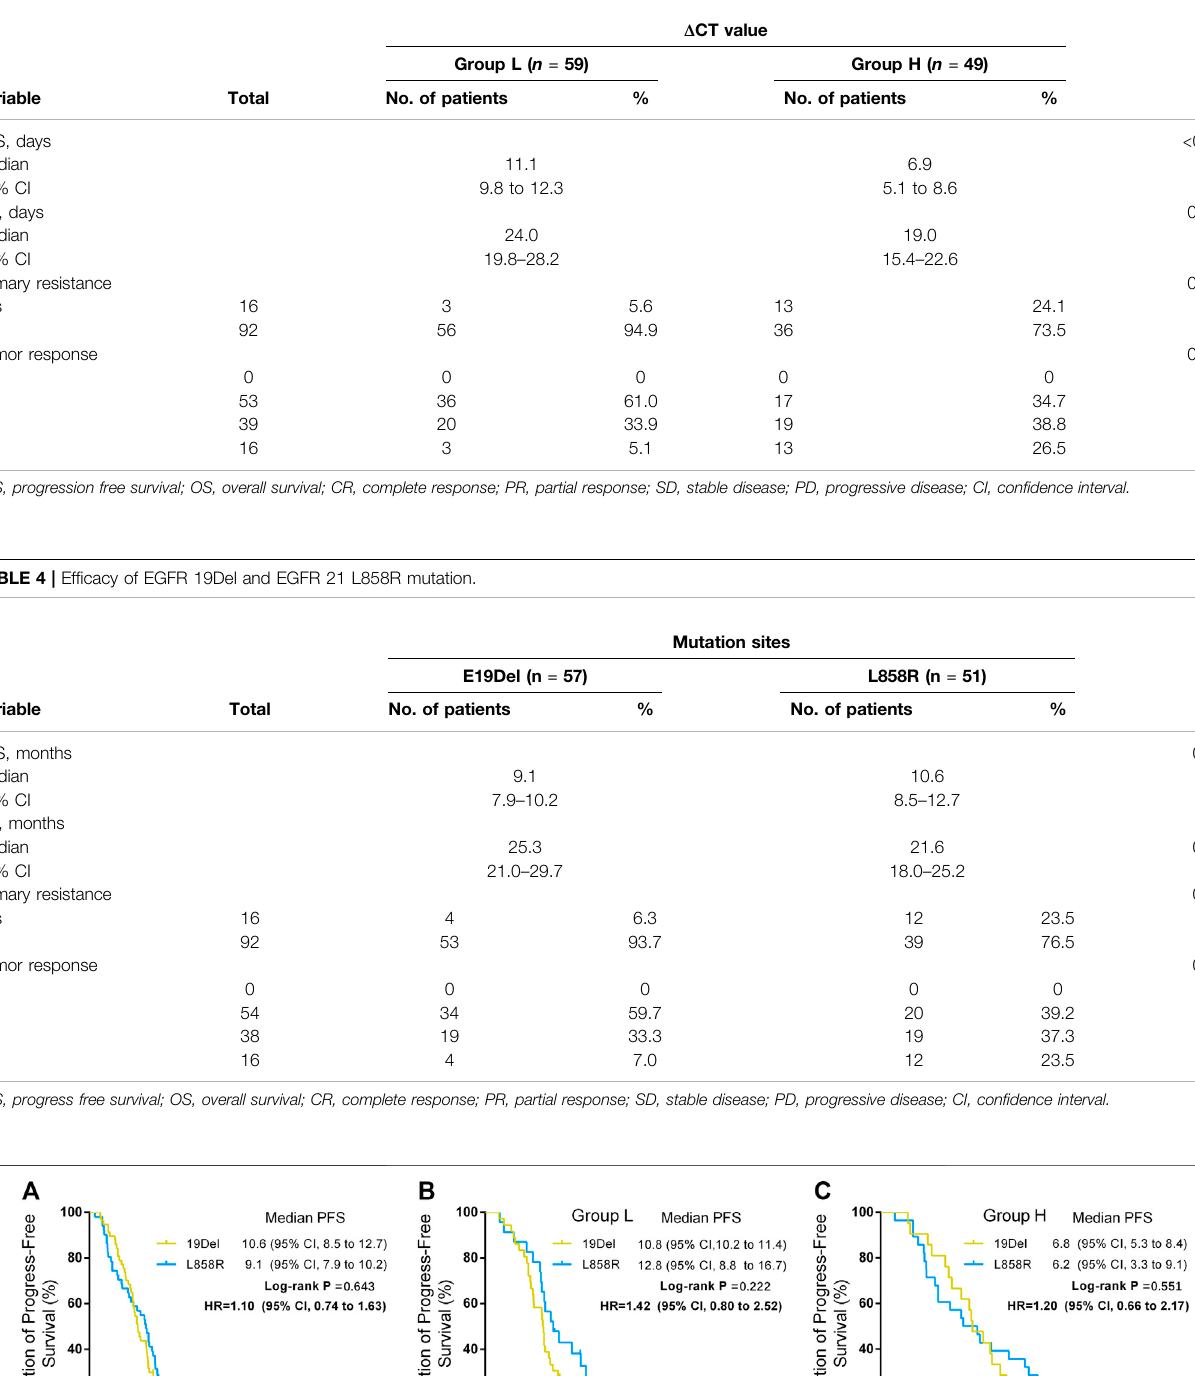
TABLE 3 | Ef fi cacy of different Δ CT value groups.